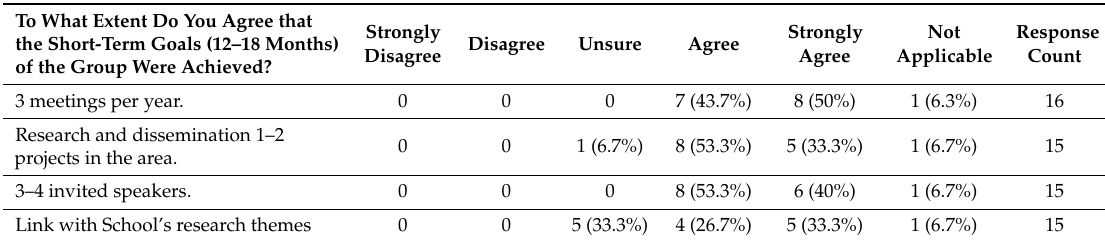
Table 3. The extent to which SIG members agree that the short-term goals (12–18 months) of the group have been